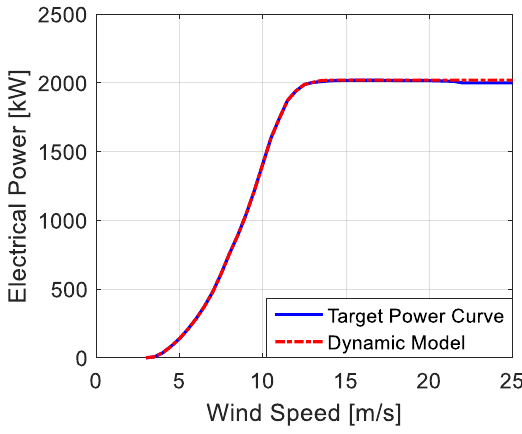
Figure 9. Comparison of the measured power curve report and the power curve of different controllers at 1.076 kg/m 3 .